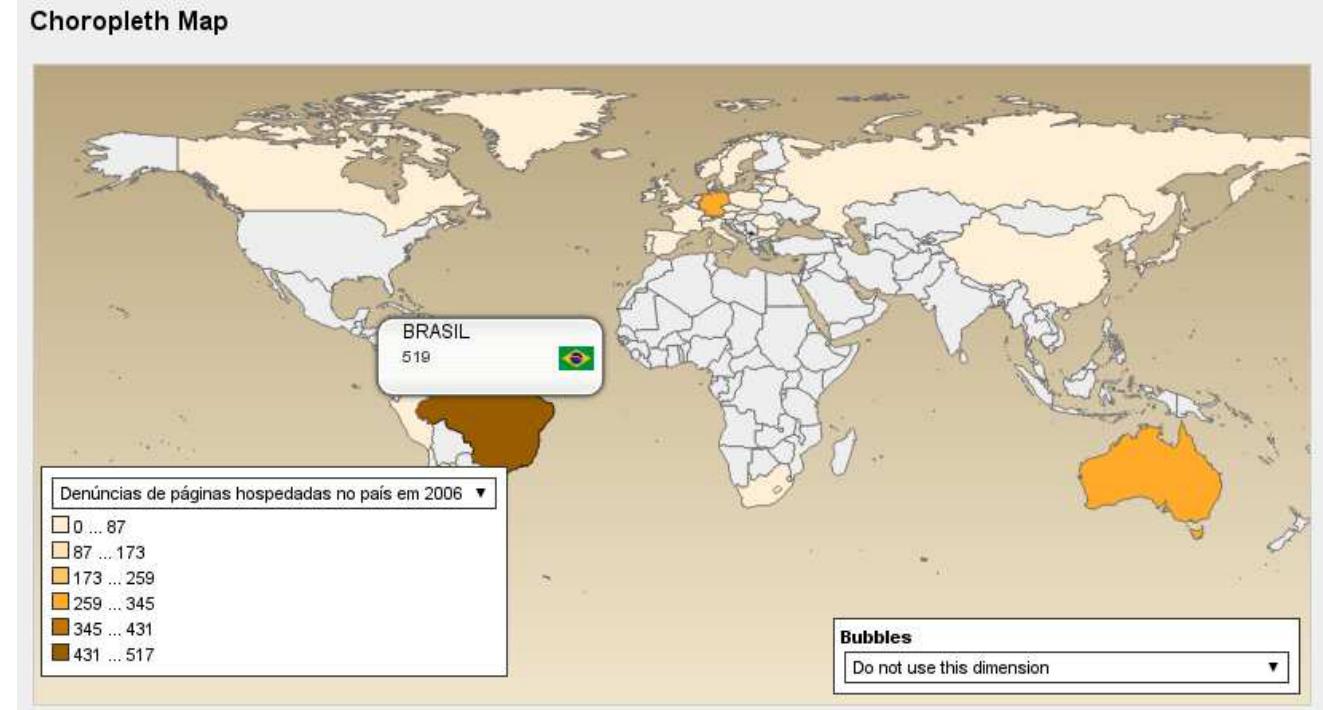
[3] Adobe, “Flash,” 2011, available at: http://www.adobe.com/br/products/flash.html (last accessed December 11, 2011). [4] J. Nielsen, “Flash: 99% 11,